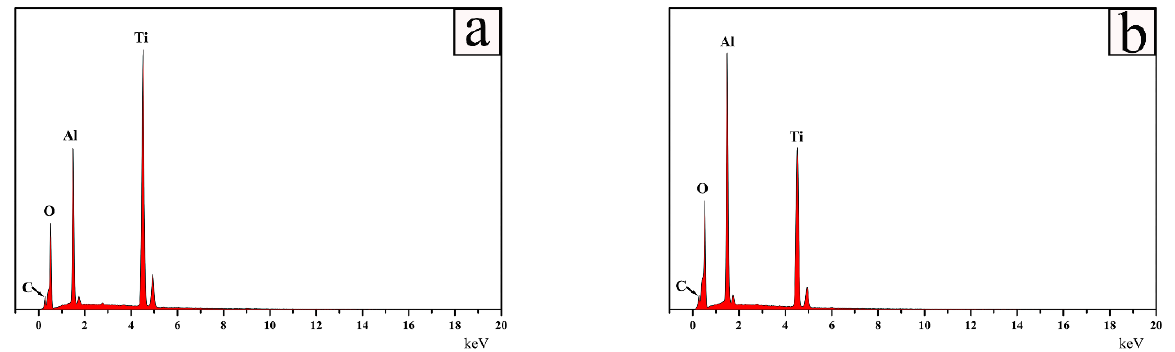
Figure 6. EDS patterns of Ti 2 AlC samples quenched in water at different temperatures: ( a ) 920 °C and ( b ) 1150 °C. Table 3. Phase compositions of the sample ’s surface of water-quenched Ti 2 AlC ceramic heated in air at different temperatures.